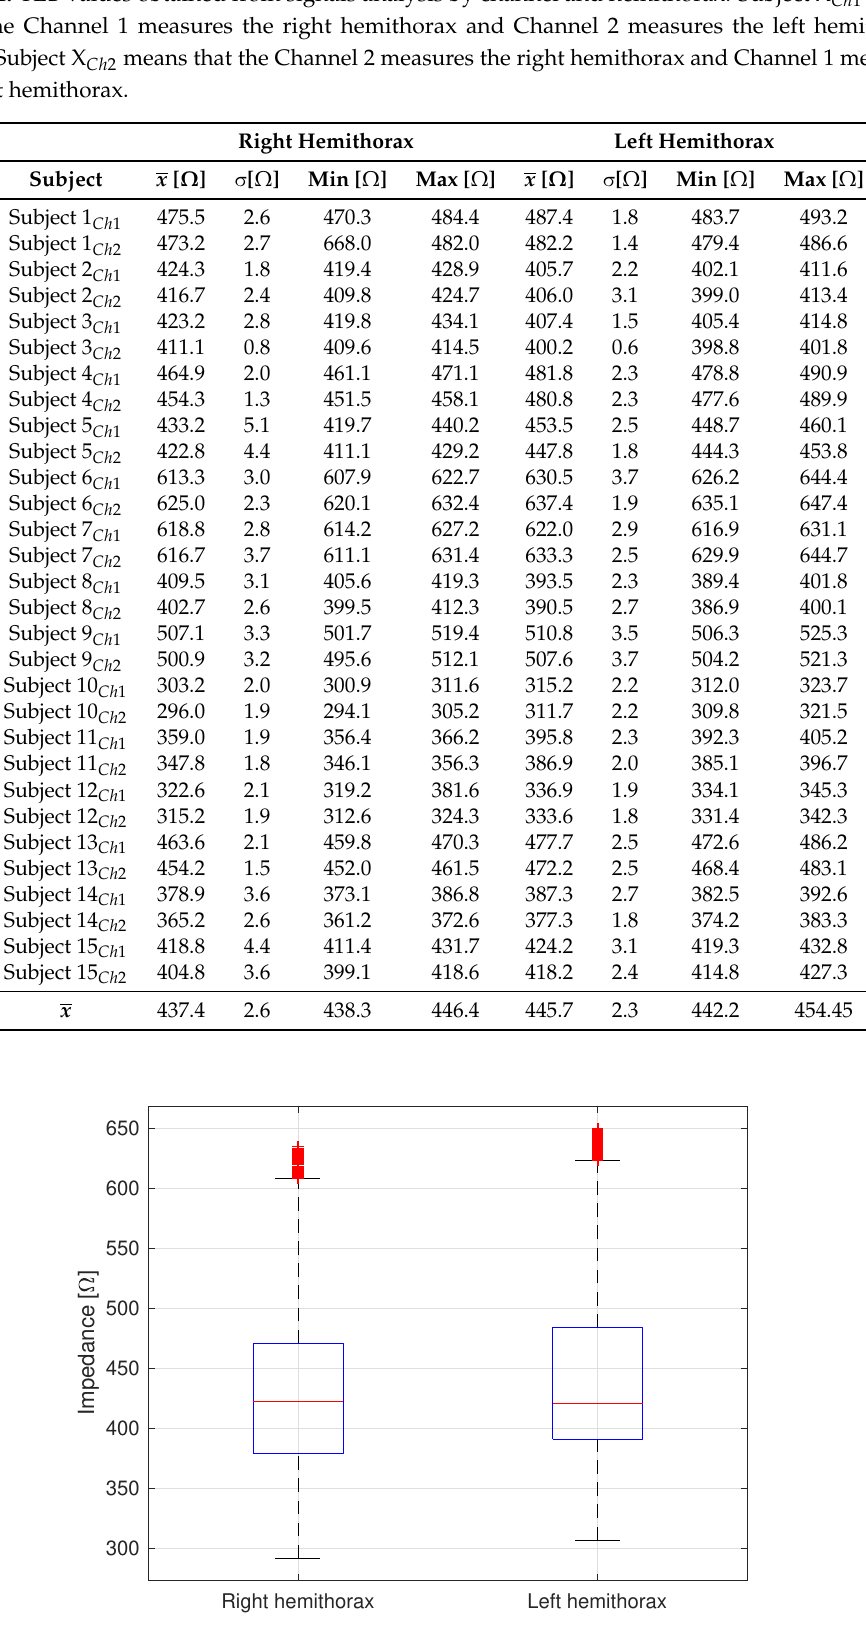
Figure 11. Boxplot of TEB values distribution for right and left hemithorax from all subjects